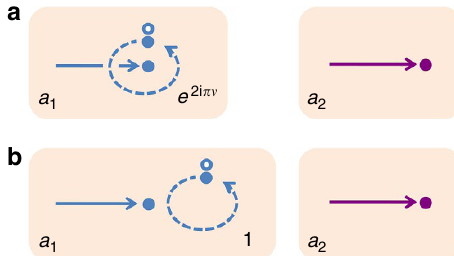
Figure 1 | Topological vacuum bubble. Feynman diagrams for interference involving a real particle and a virtual particle–hole excitation from vacuum. Full (empty) circles represent particles (holes). Solid (dashed) lines denote propagations of real (virtual) particles. ( a ) Diagram for the interference a 1 a (cid:2) of two processes: ( a 1 , blue) A real particle propagates, a virtual particle– hole pair is excited, then the pair self-annihilates after the virtual particle winds around the real one. ( a 2 , magenta) A real particle propagates. The entire virtual process constitutes a vacuum bubble. For anyons, the bubble gains a topological braiding phase 2 pn from the winding. ( b ) Partner diagram of a . Here a virtual particle, constituting another bubble, does not encircle a real one and hence gains no braiding phase. The diagrams in a and b contribute to observables for anyons, while they do not for bosons and